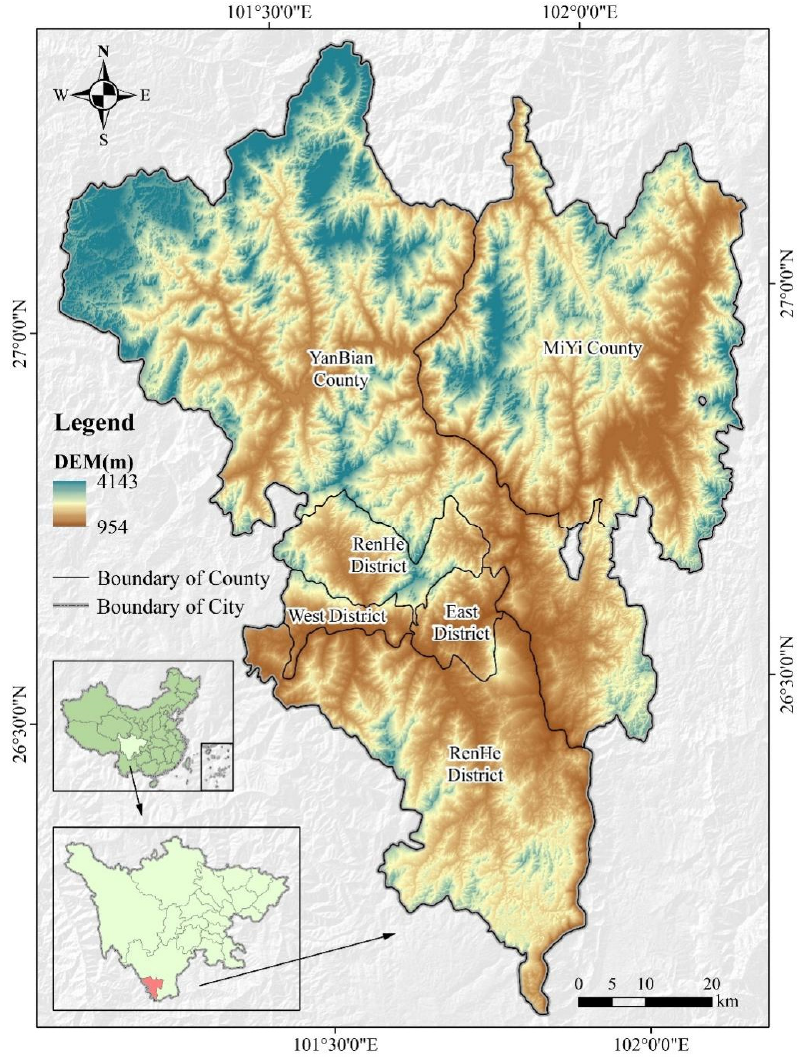
Figure 1. Overview map of the study area.